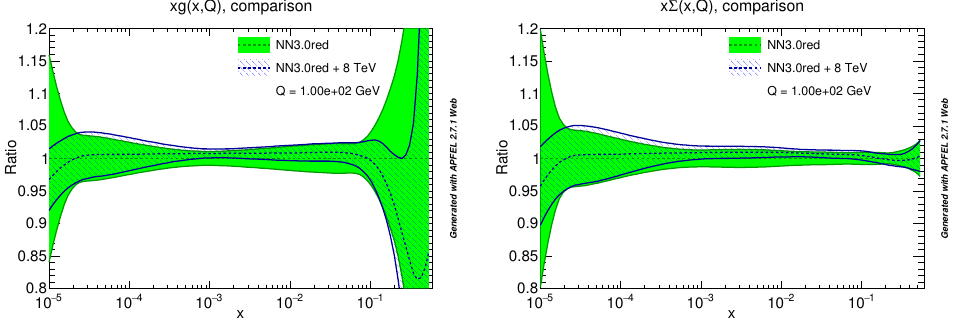
data on the global gluon and singlet-quark T